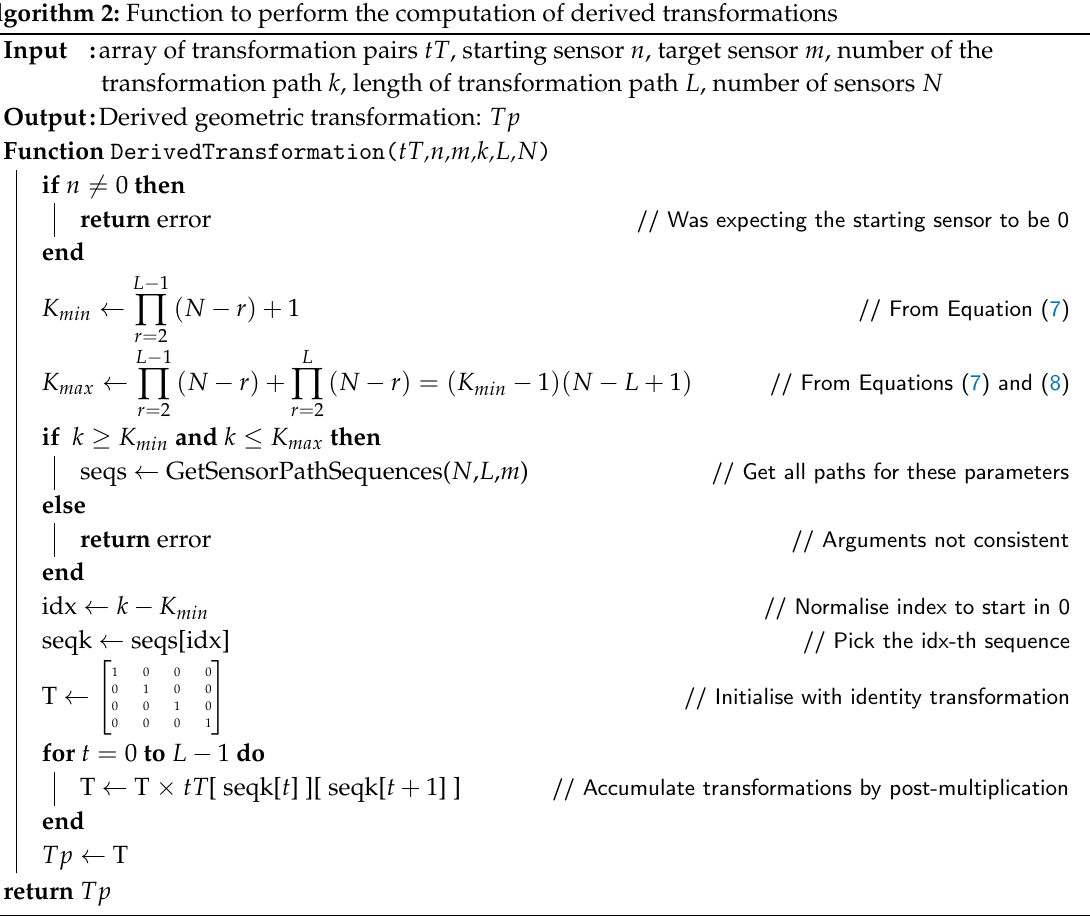
Algorithm 3: Simplified function to compute derived transformations with L = 2 Input : array of transformation pairs tT , target sensor m , number of the transformation path k , number of sensors